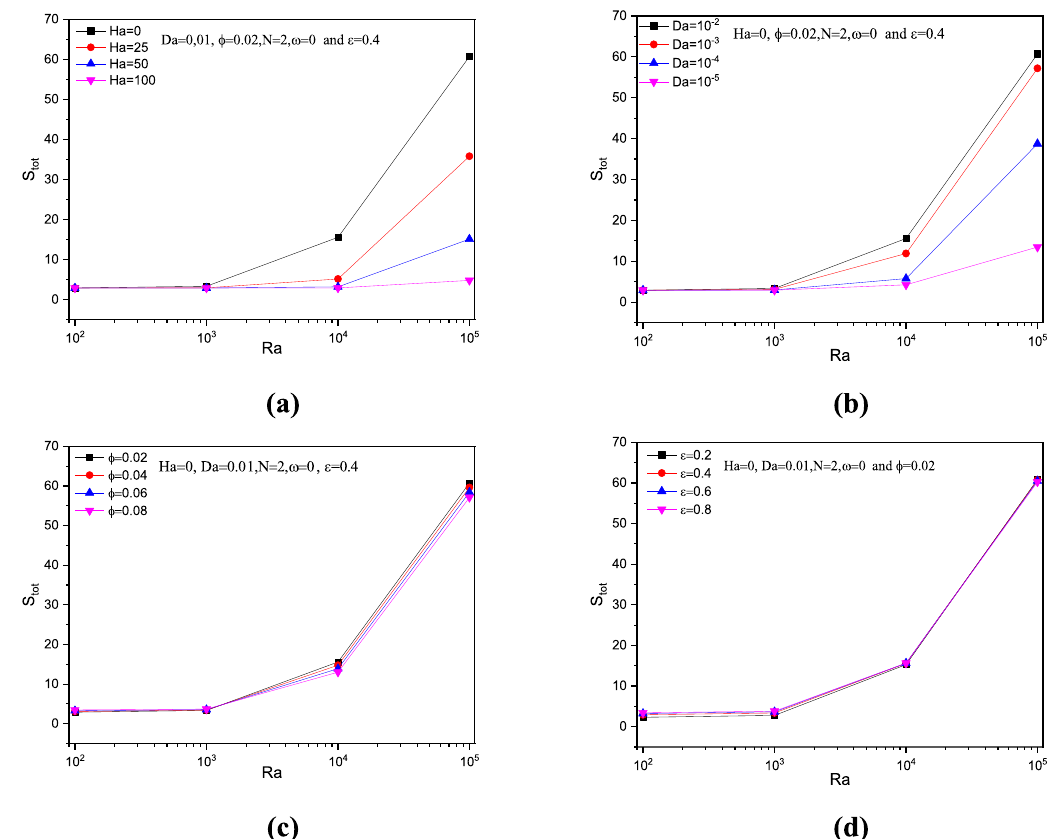
Figure 21. Variations of total entropy with various Rayleigh number Ra for variation Ra , Ha , φ , ε at N 0 . ω =